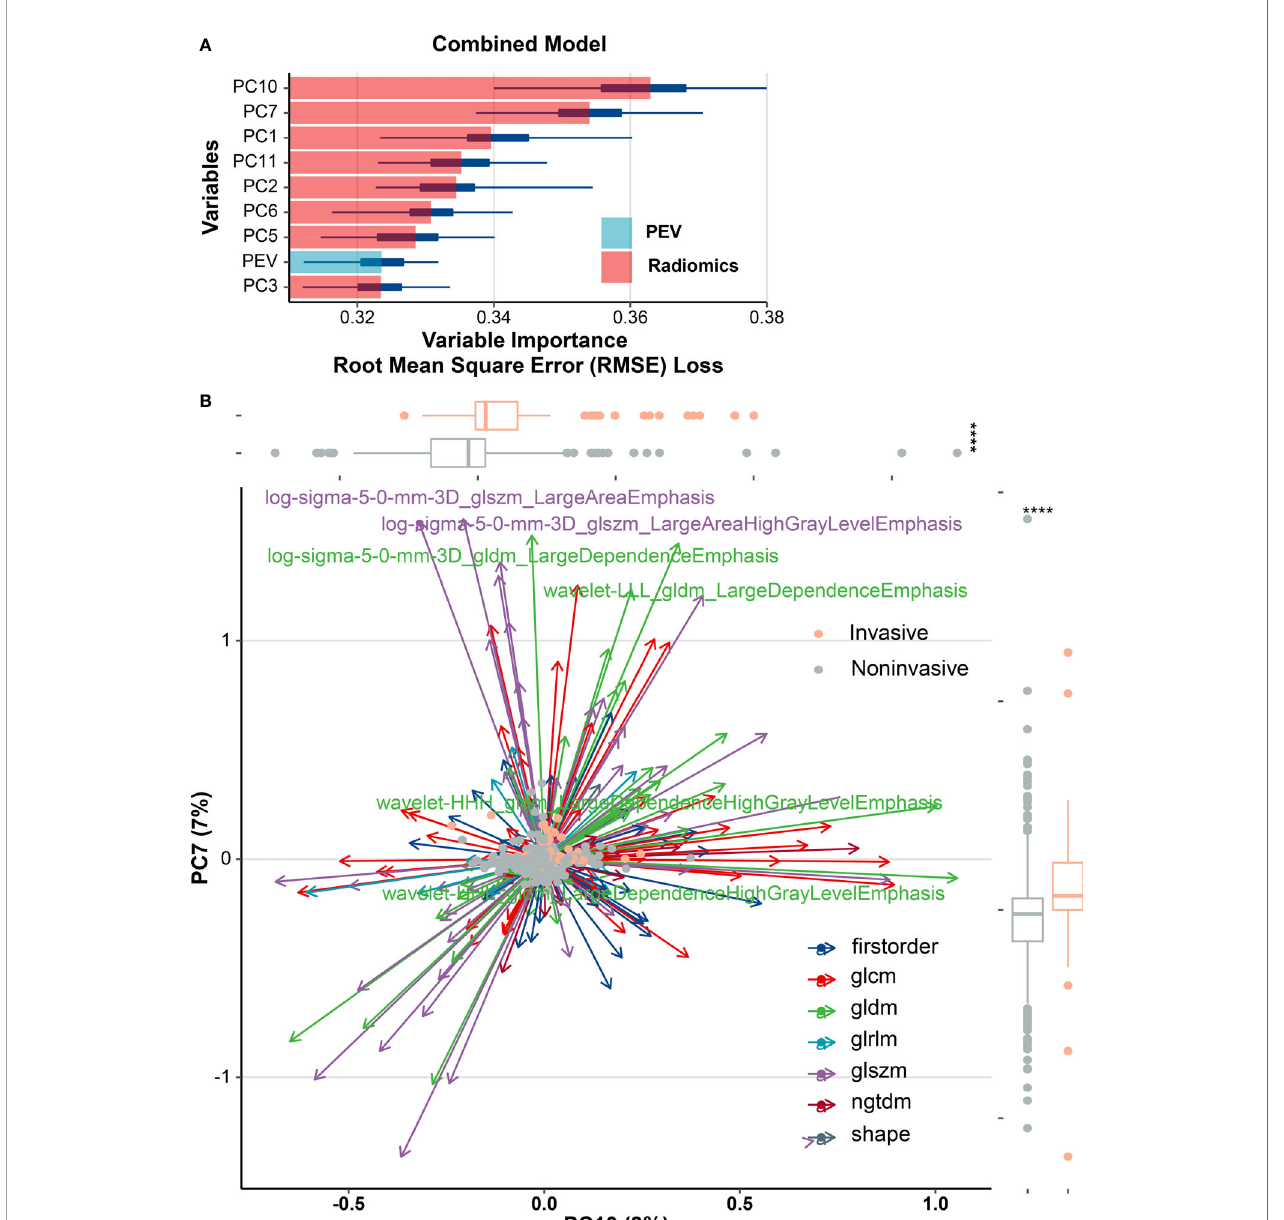
FIGURE 6 | Multiple types of radiomics features associated with brain invasiveness in the combined model. (A) Variable importance for classi fi cation of event in combined model. (B) Radiomics feature-based principal component analysis (PCA) of tumor invasion. PCA shows that PC10 and PC7 are almost able to distinguish the invasive and noninvasive groups of meningiomas and the multivariate variation of different radiomics features of PC10 and PC7. A total of six features including gray-level co-occurrence matrix (GLCM) and gray-level dependence matrix (GLDM) were subjected to PCA, and those features with variable loading for PC7 ≥ 0.7 or PC10 ≥ 0.5 were shown as major contributors. Box plots show the overall distribution of PC10 and PC7 scores within tumor invasion (Wilcoxon rank-sum test). PEV, peritumoral edema volume; **** p <